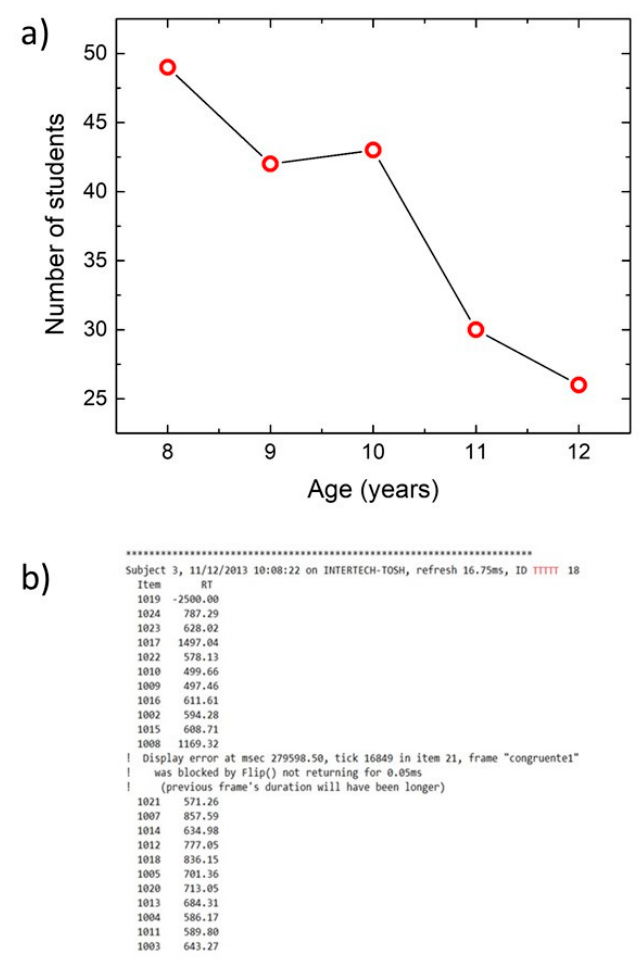
Figure 1. The age distribution of the sample is shown in panel ( a ) and a fragment of a *.azk output file in panel ( b ). In order to protect the privacy of the child who performed the experiment, the characters “TTTTT” have been used as a pseudonym for the actual name.